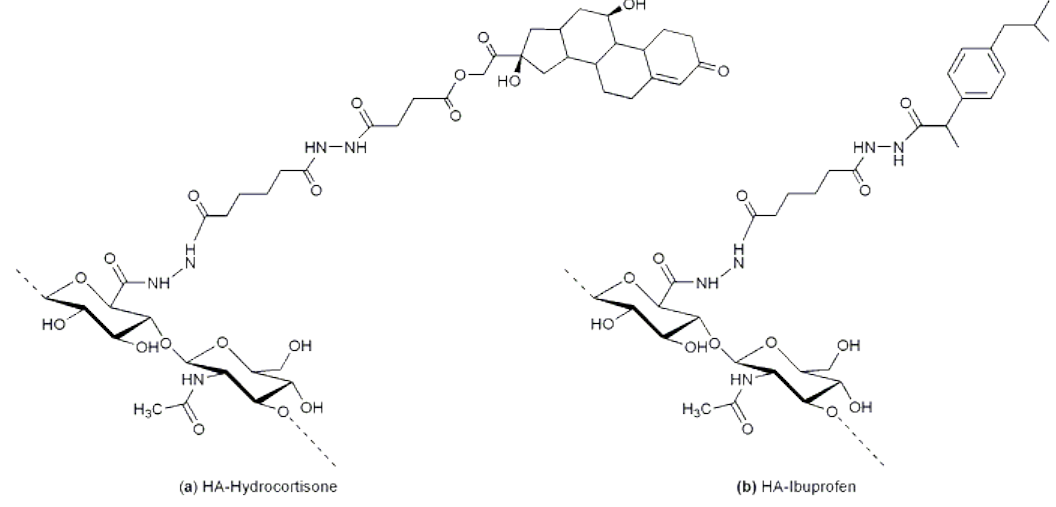
Figure 7. ( a ) HA-hydrocortisone: the HA-ADH derivative was conjugated to a hemisuccinate derivative of hydrocortisone previously activated with NHS [55]; and ( b ) HA-ibuprofen: the HA-ADH derivative was conjugated to an activated ester of ibuprofen, using a carbodiimide and NHS